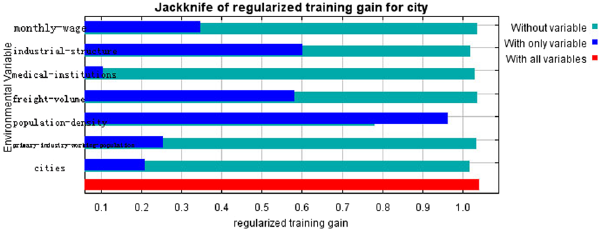
Figure 4. Maxent jackknife method (The jackknife figure reflected the impact of each variable on the entire model and reflected the function and signification of each variable in more detail. Light blue indicates the impact on the model if this variable is not included, and dark blue indicates the independent contribution of this variable to the